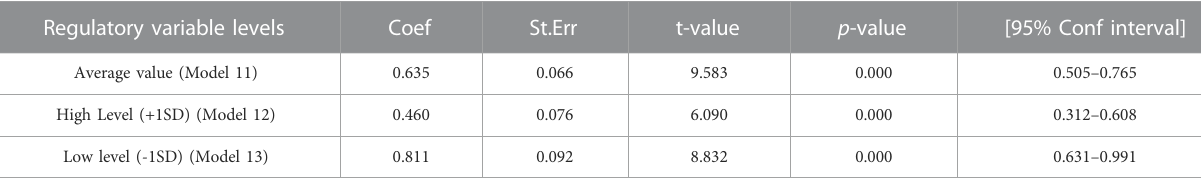
TABLE 7 Analysis of the regression results at different levels of farmers ’ attitude toward risk.